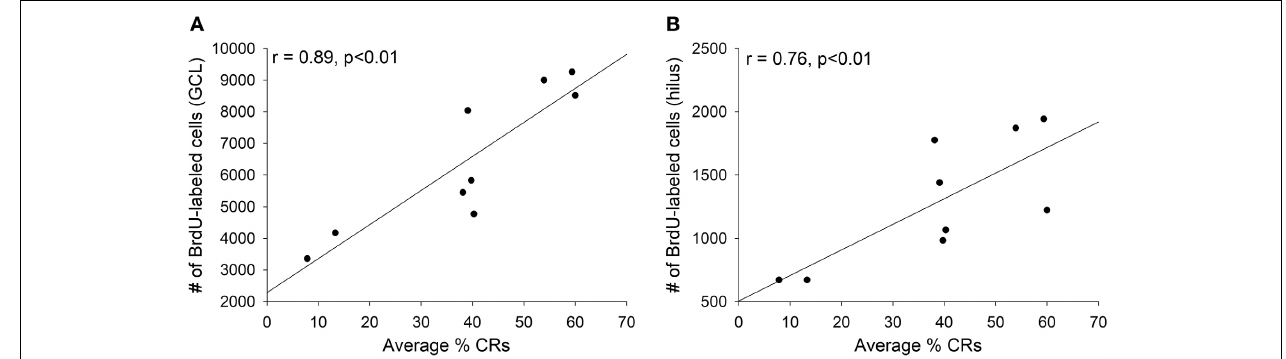
FIGURE 4 | Animals that successfully acquired the conditioned response retained more new cells than those that failed to learn. Across all trained animals strong positive correlations were observed between the average